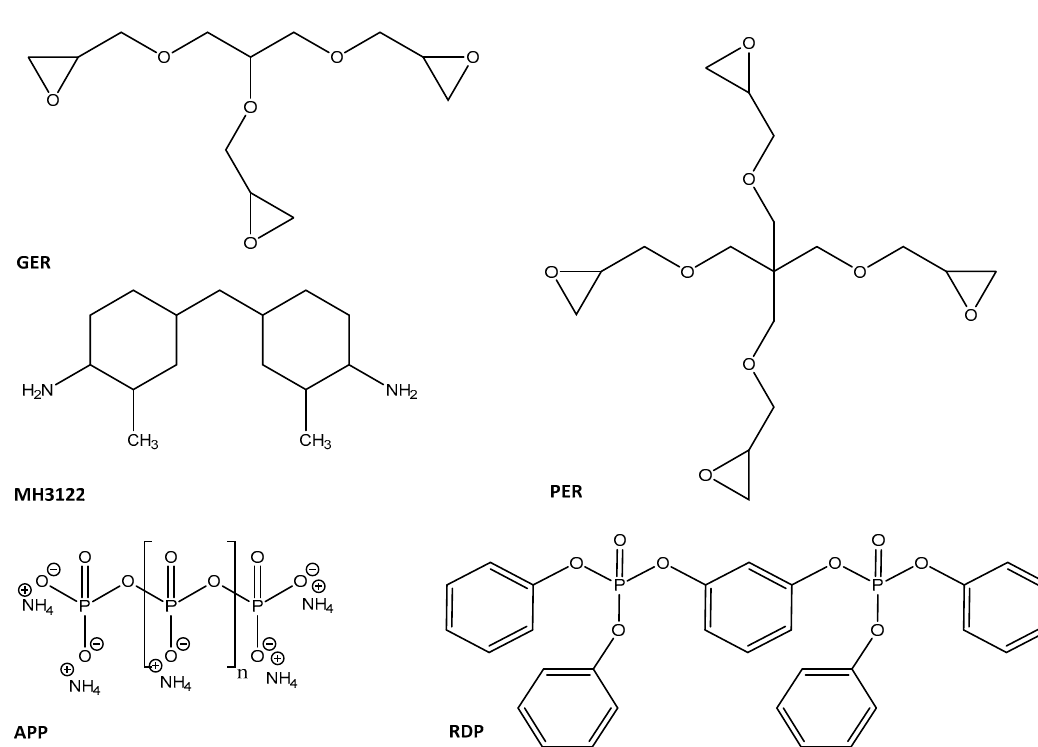
Figure 1. Chemical structures of the main components of the components applied: triglycidyl ether of glycerol (GER), tetraglycidyl ether of pentaerythritol (PER), 3,3 ′ -dimethyl-4,4 ′ -diaminodicyclohexylmethane (MH 3122), ammonium polyphosphate (APP) and resorcinol bis(diphenyl phosphate) (RDP).